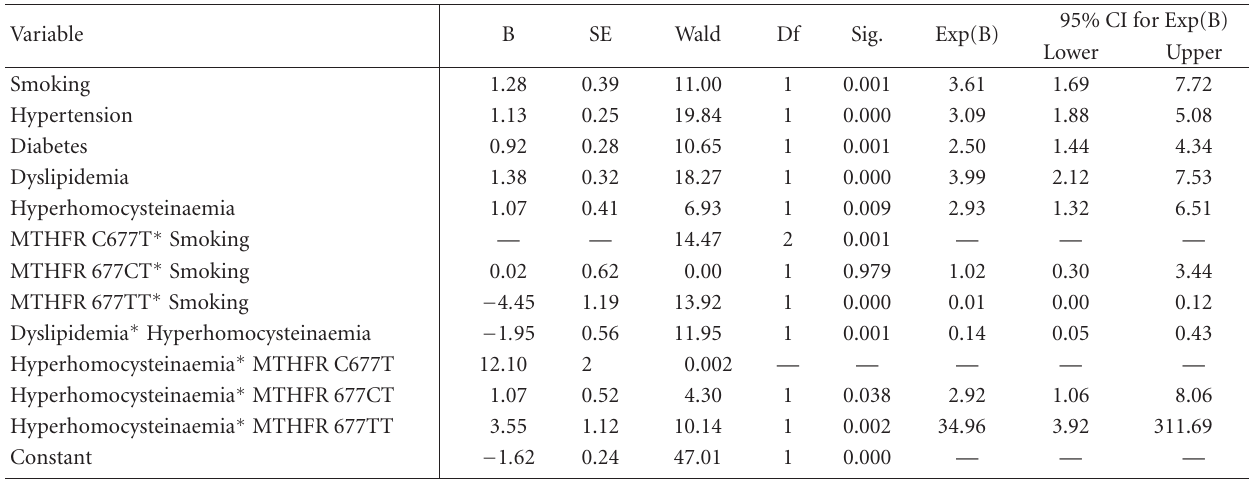
Table 6: Cardiovascular risk factors that are having a significant e ff ect on CAD. Logistic regression model with backward likelihood ratio method. B: the logistic regression coe ffi cient; SE: standard error; Wald: statistic value of Wald; Df: degree of freedom; Sig.: significant value; Exp(B): exponential of B; 95% CI: 95% confidence